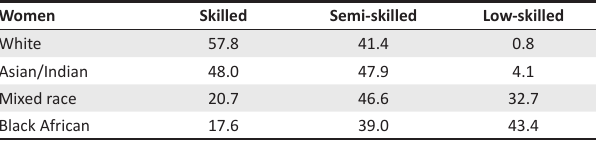
TABLE 1: Employment by occupation, population group and sex, Q3: